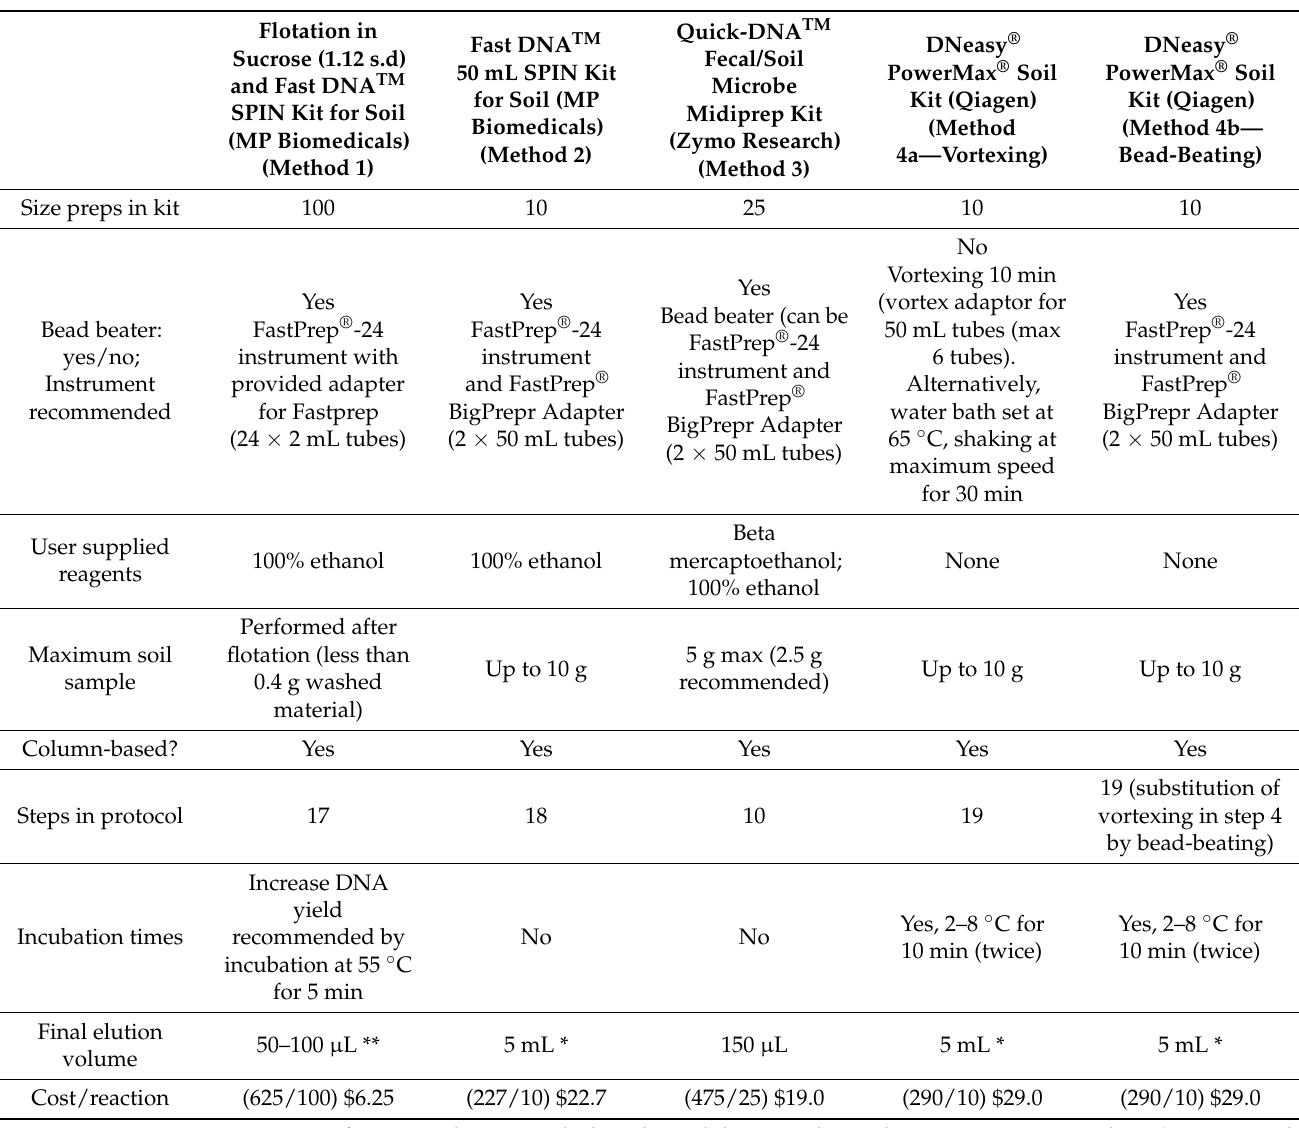
Table 1. Characteristics of three commercial DNA isolation kits for soil and a concentration by flotation protocol following by DNA isolation as in BAM Chapter 19b, used in this study to extract genomic DNA from soil samples inoculated with 100 oocysts of Cyclospora cayetanensis